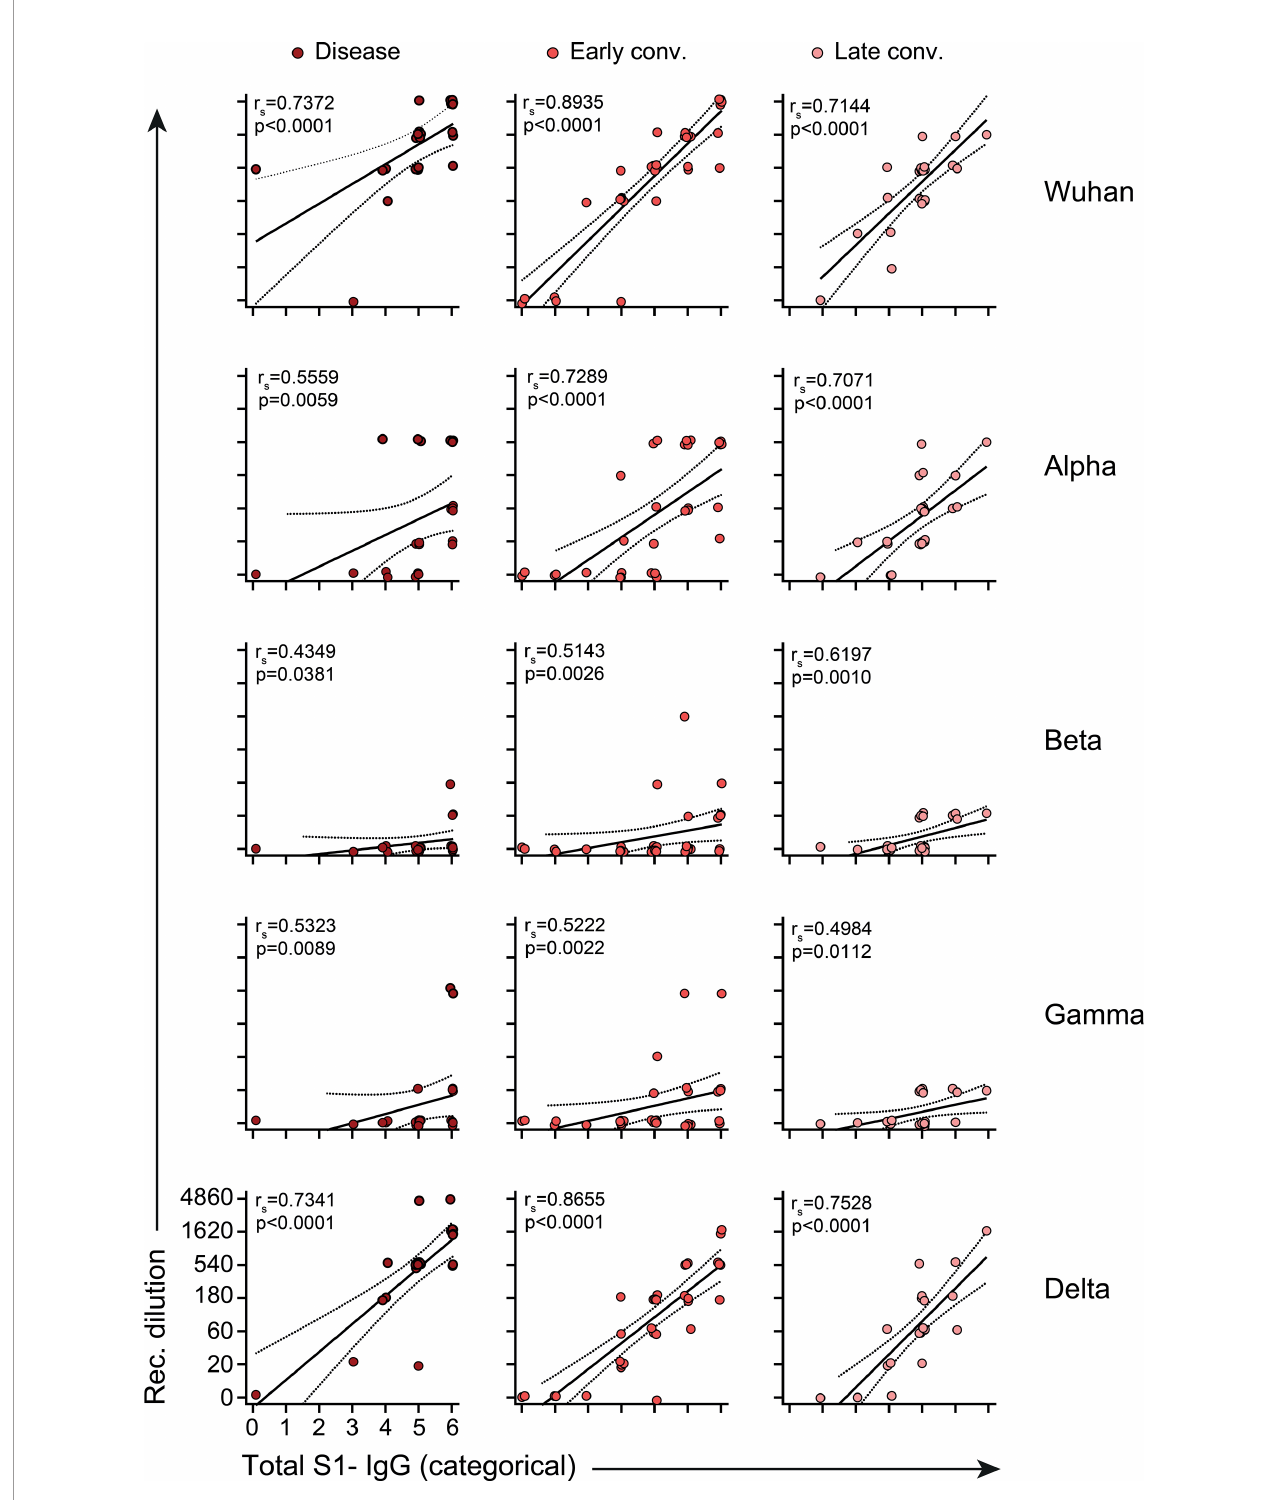
FIGURE 5 | Correlate of total anti-Spike S1-IgG and neutralization antibody titers. Lines represent linear regression and dotted lines 95% con fi dence interval. Each dot represents one biologically individual sample taken from one patient. N (disease)=23; n (early conv.)=32; n (late conv.)=25. Absolute values of Spike-IgG (in RU/ml) were transformed into 7 categorical variables as described in Supplementary Table 3 . For better visualization of identical titer values, data were randomly and proportionally adjusted closely around the precise titer results. Statistics: nonparametric Spearman correlation. r s = Spearman ’ s correlation coef fi